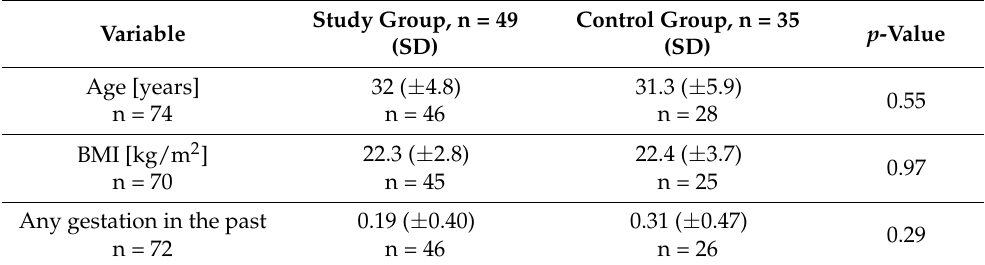
Table 1. Baseline characteristics of the studied groups. The given values are the arithmetic mean. SD—standard deviation.